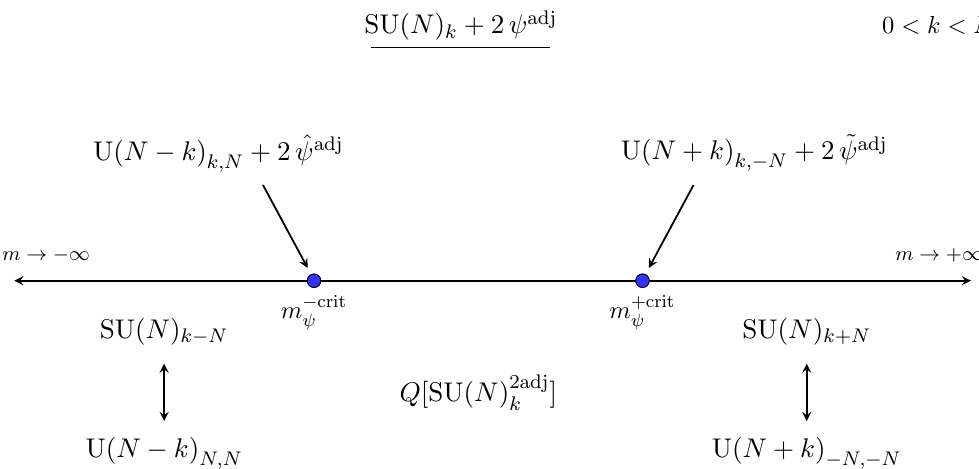
Figure 7 . Phase diagram of SU( N ) with two real adjoint fermions for 0 < k < N . The solid circles represent a phase transition between the asymptotic phases and the intermediate quantum phase. Each phase transition has a dual gauge theory description, which appears with an arrow pointing to the phase transition. The mass deformations are related by (cid:14)m = (cid:0) (cid:14)m ^ and (cid:14)m = (cid:0) (cid:14)m ~ . Importantly, the right dual description is always strongly coupled and left dual description is weakly coupled only when N= 2 (cid:20) k < N